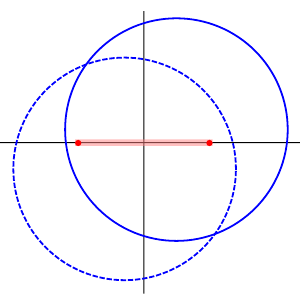
Figure 2. For the entanglement entropy of an interval of length L < R , there is also a contribution from multi-walled instantons. This example shows a con(cid:12)guration in the case n = 2; the solid and dotted line instanton walls lie on di(cid:11)erent